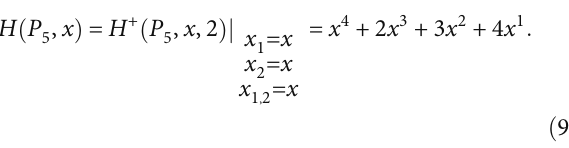
Figure 1: The graph P